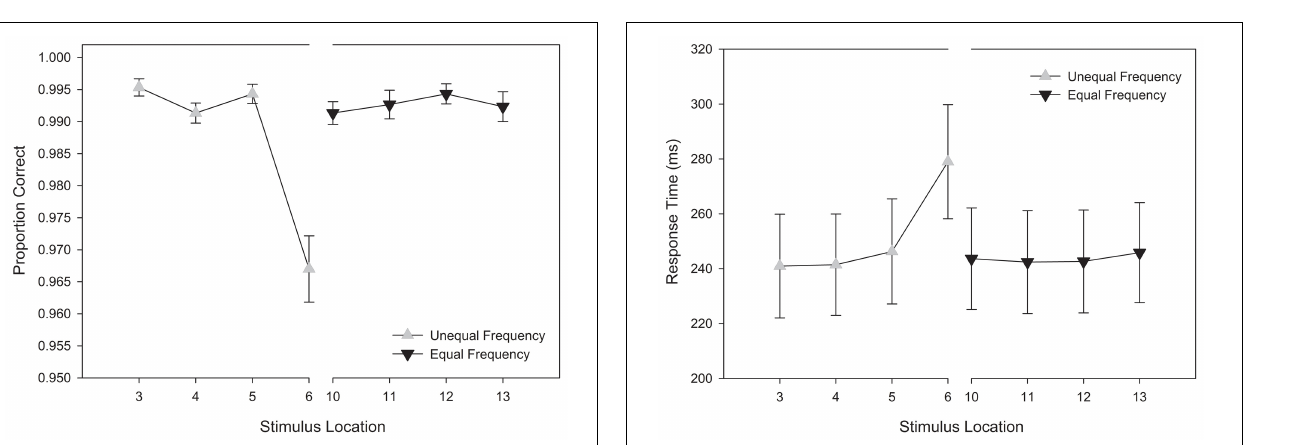
FIGURE 10 | Training categorization response accuracy in the unequal frequency, unequal distribution condition. Stimulus values correspond to stimuli selected from the training range (i.e., stimuli 3–13). Error bars represent 1 standard error of the mean ( N = 60).